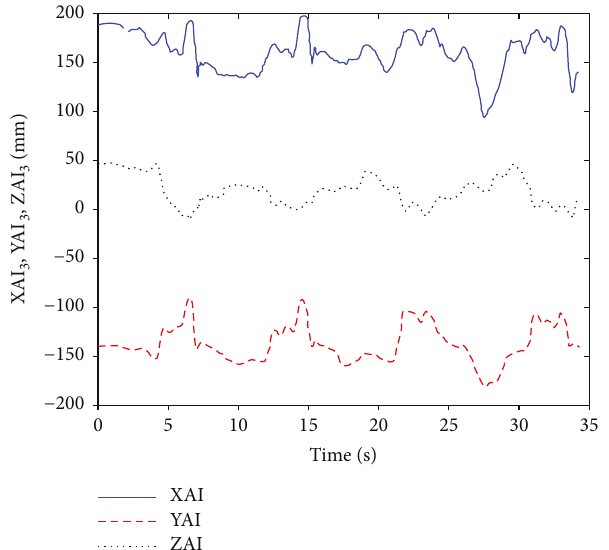
Figure 9: The position vector of AI described in ellipsoid frame S